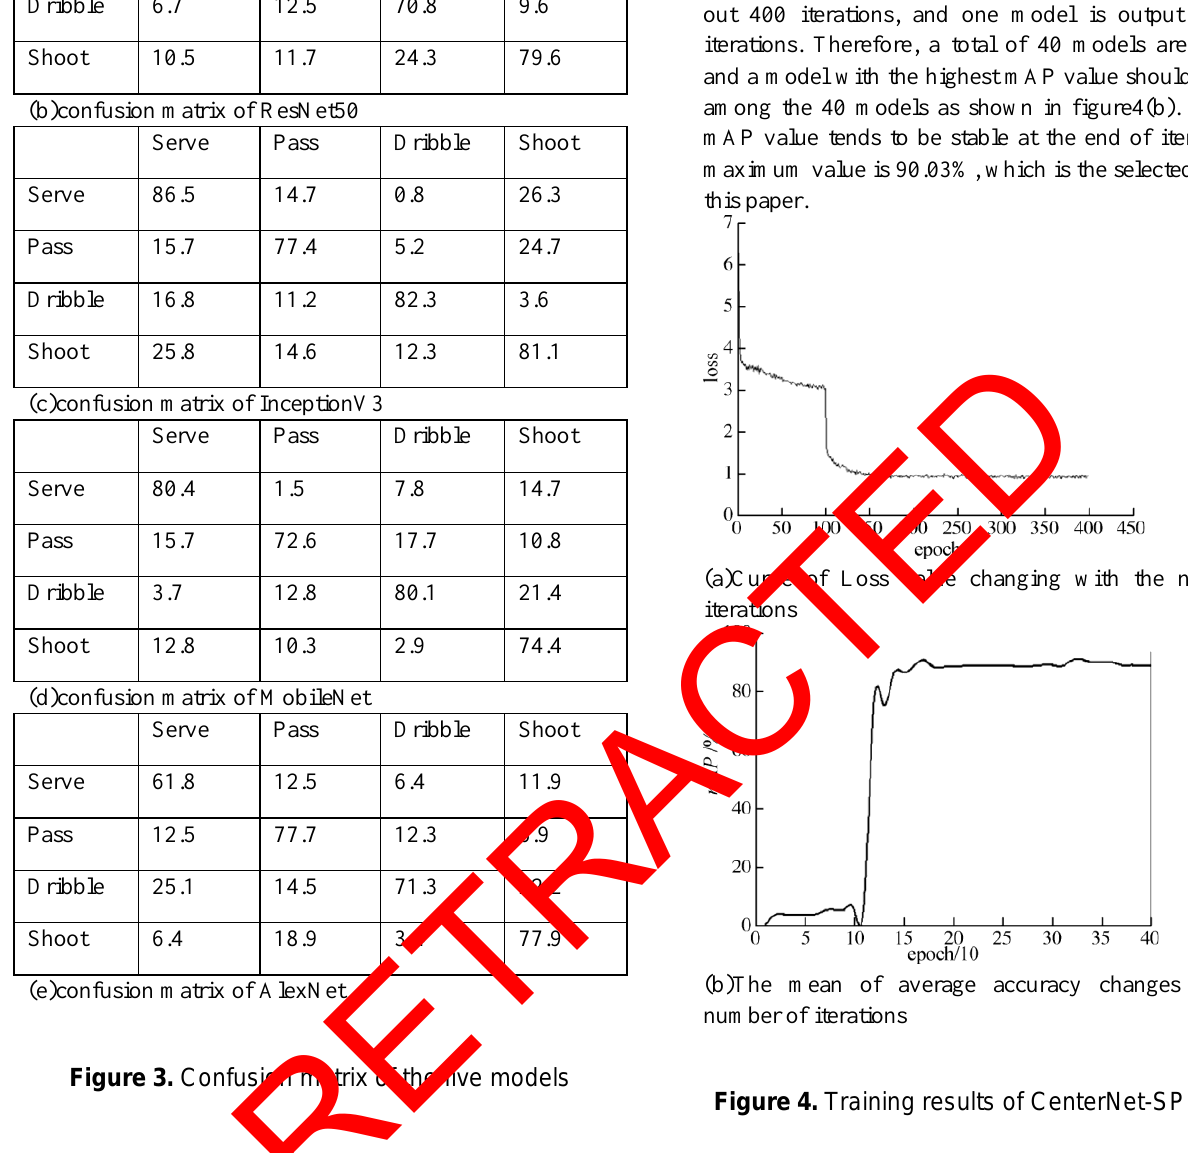
Figure 4. Training results of CenterNet-SPP